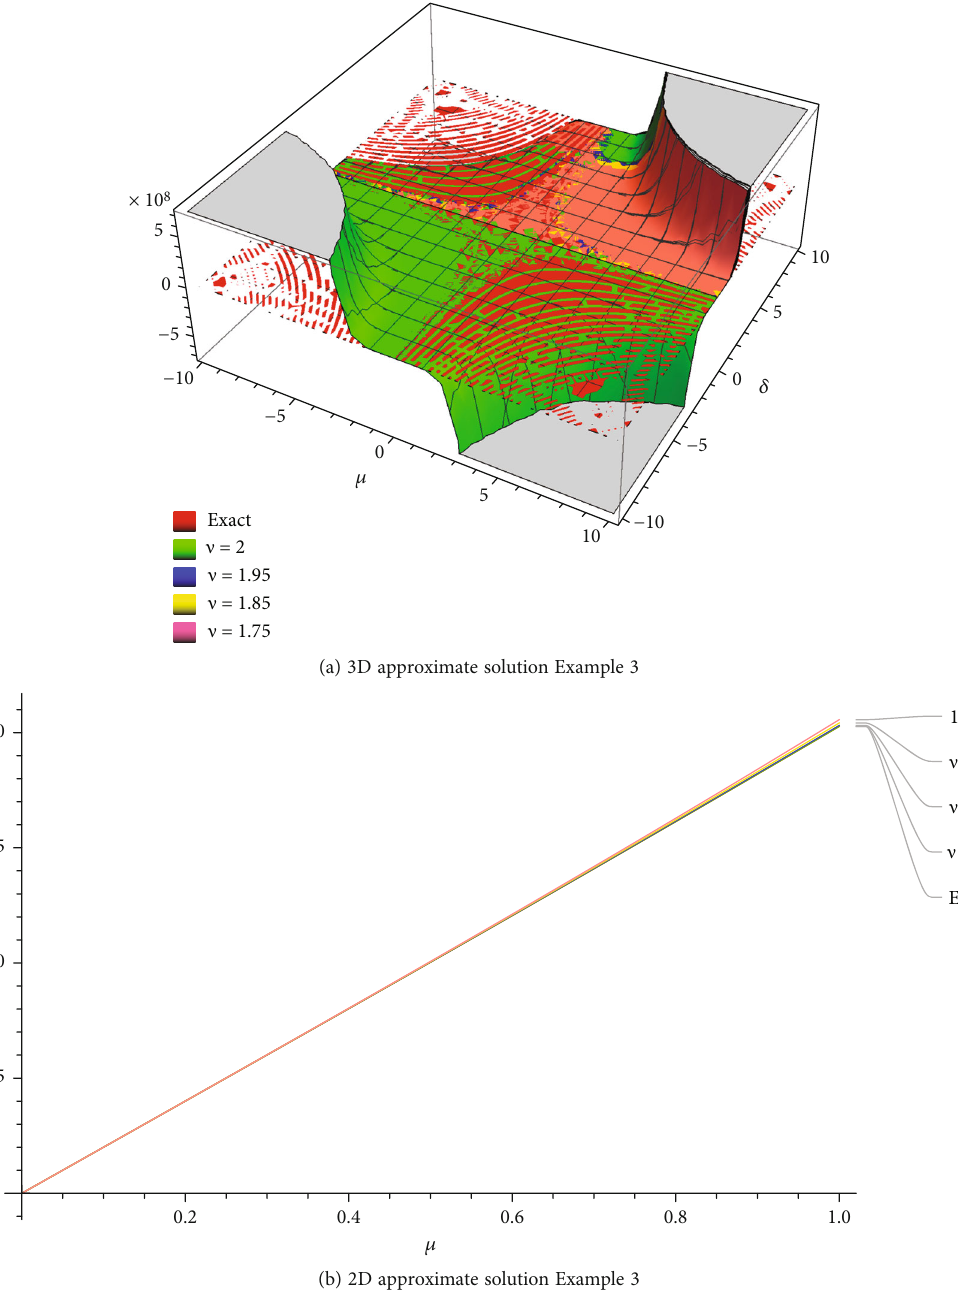
Figure 3: Create 2D and 3D comparison charts of precise data and predicted computational outputs for Example 3, using δ = 0 : 2